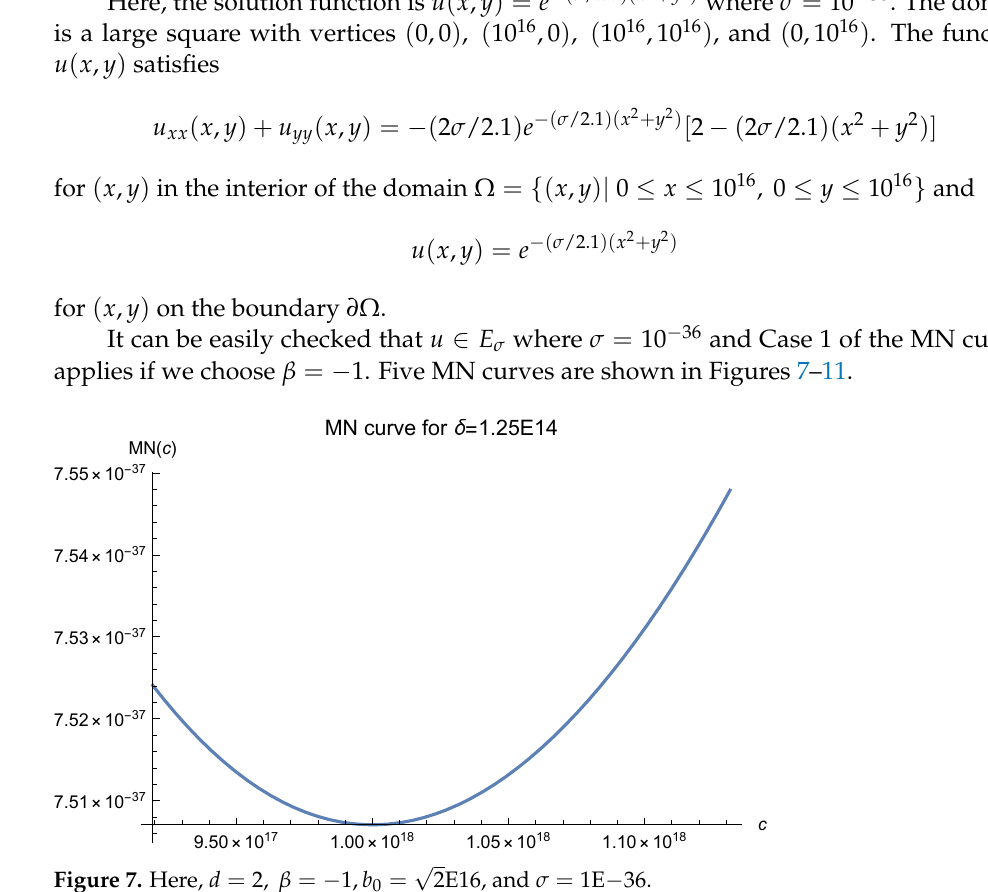
Figure 7. Here, d = 2, β = − 1, b 0 =